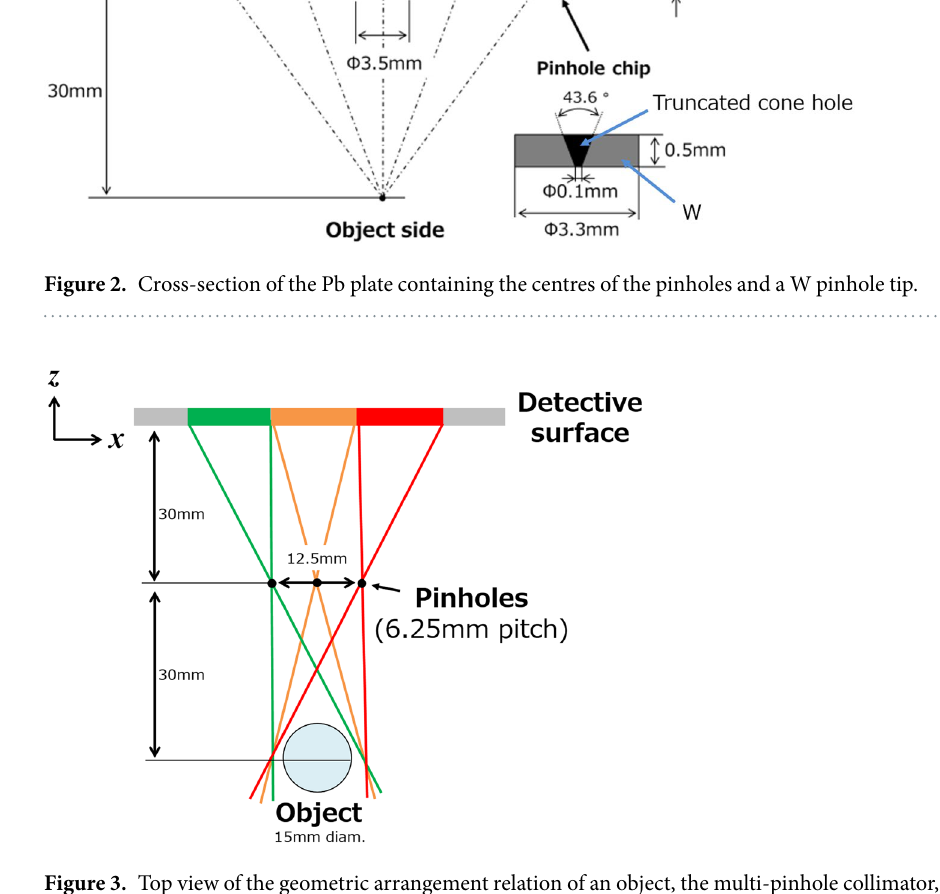
Figure 3. Top view of the geometric arrangement relation of an object, the multi-pinhole collimator, and the